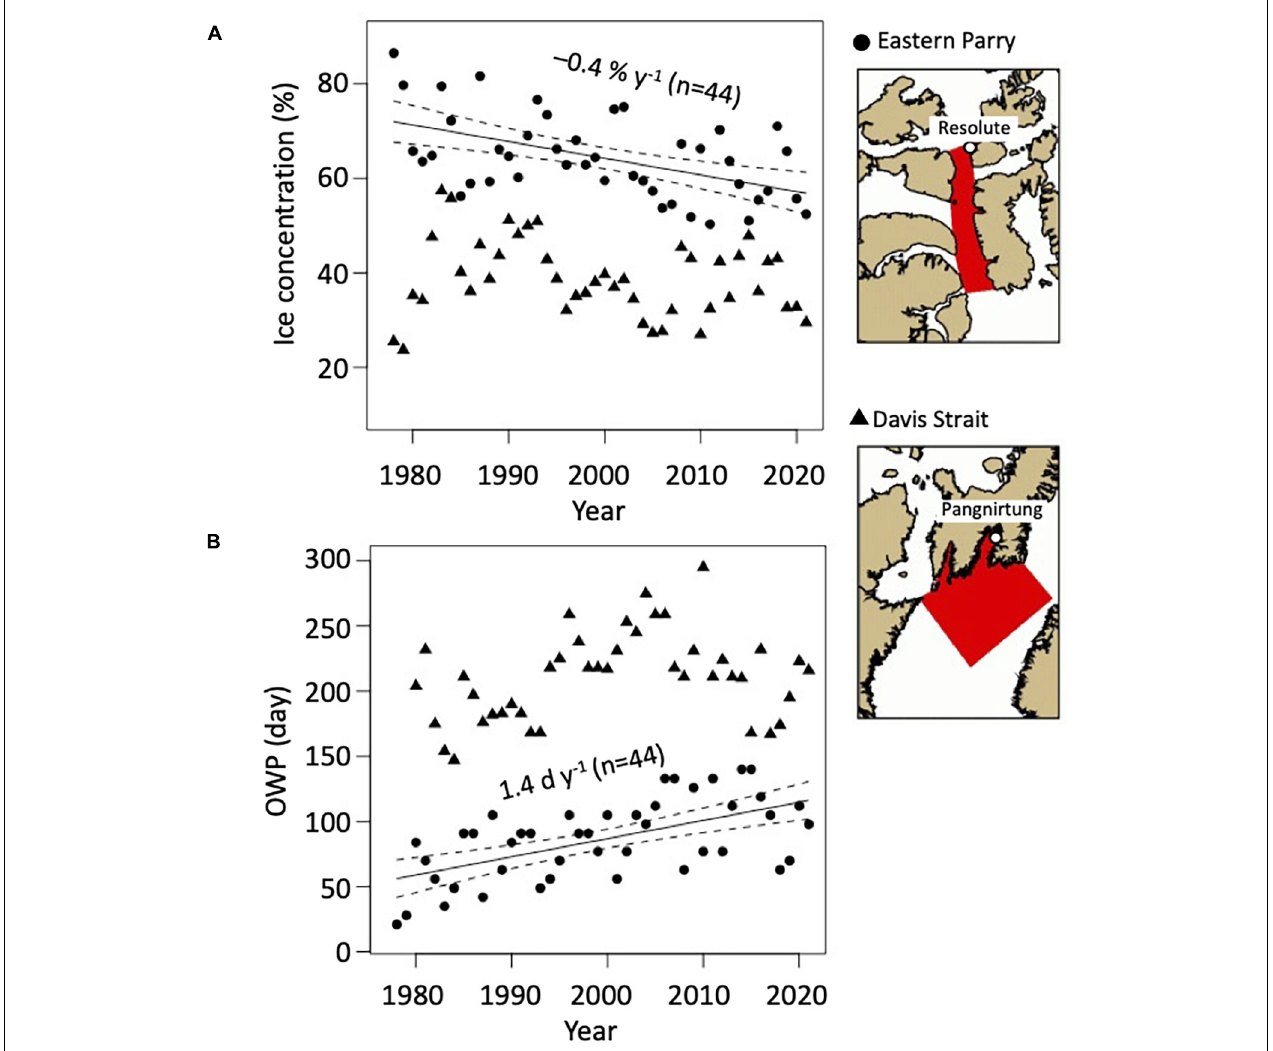
FIGURE 2 | (A) Decadal trends in mean sea ice coverage (%), averaged over the time period integrated in ringed seal muscle (February–September) and (B) open water period (OWP) in ordinal day; the slope of the linear models (solid lines; p < 0.01) and 95% confidence interval (dashed lines) are shown on the graphs; n , number of data points; the circles show the data extracted in Eastern Parry (Canadian Arctic Archipelago) and the triangles show the data extracted in Davis Strait (Baffin